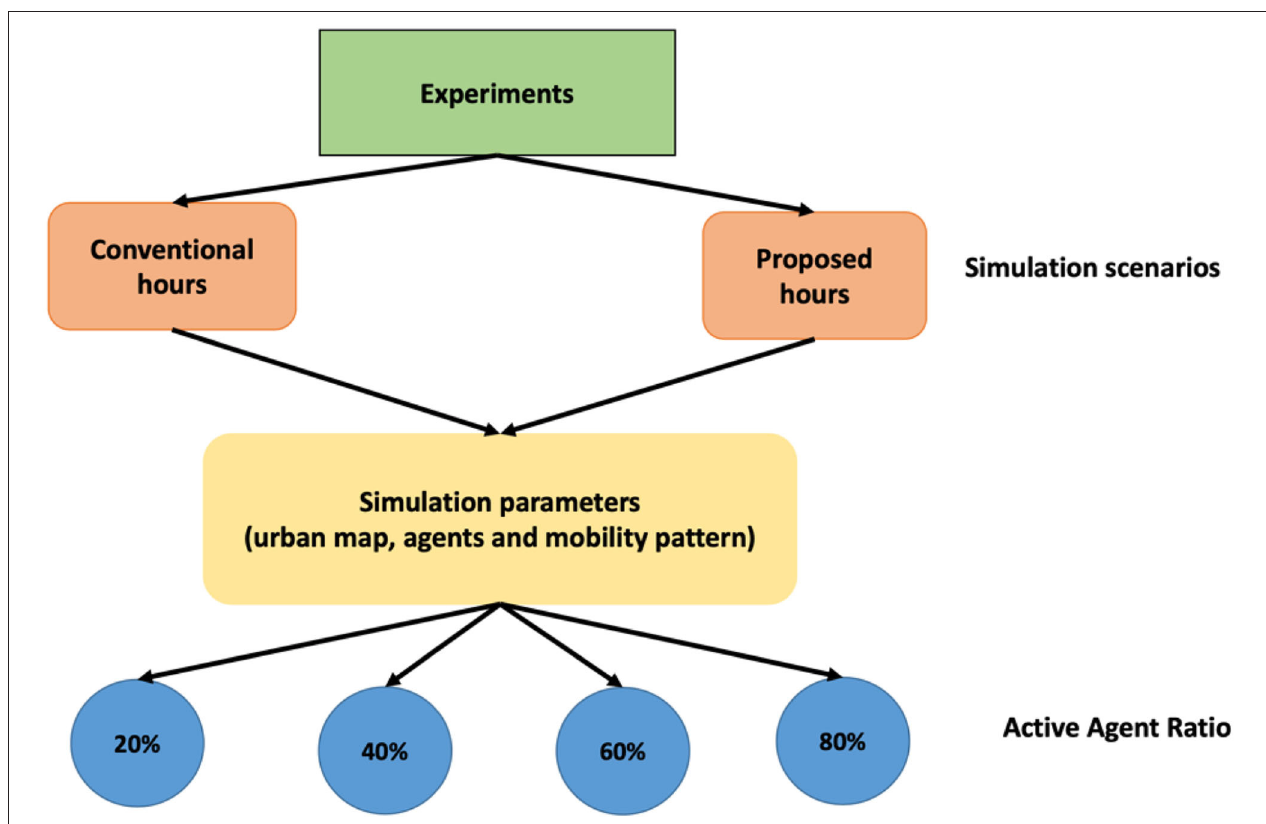
FIGURE 5 | Parameters sweep plan (source: the authors).